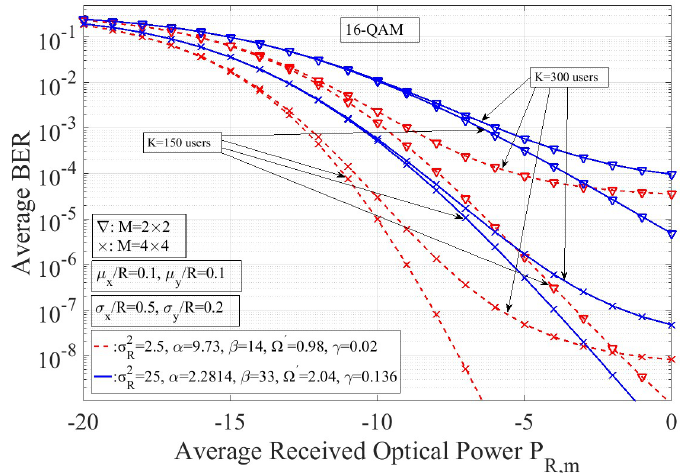
Figure 4. The ABER performance for the forward CDMA RoFSO link with receivers’ diversity, over strong turbulence and enhanced PE impact for different values of the number of users K .